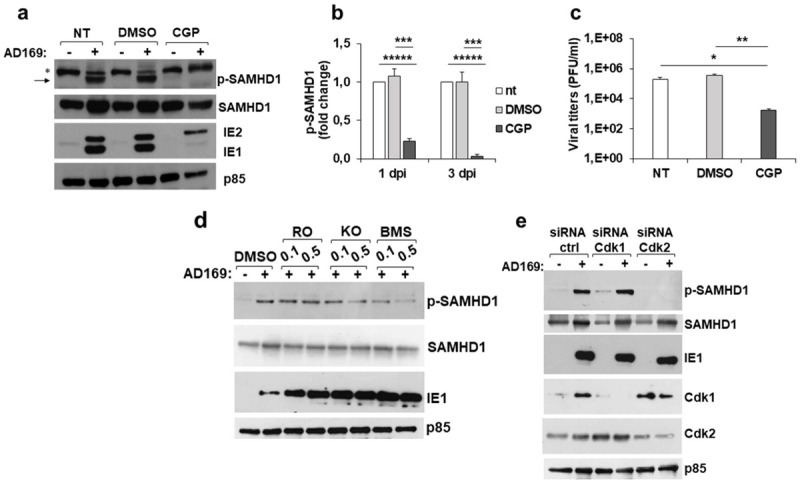
Inhibition of Cdk2 abrogates T592 phosphorylation.a) HFFs were pretreated for 5 h with the Cdk1 inhibitor CGP74514A (CGP), and then not infected or infected with AD169, in the presence of CGP. After removing virus inoculum, the inhibitor was newly added and kept until cell harvesting, at 3 dpi. Total or pT592-SAMHD1 levels were analyzed by immunoblotting, together with IE1/IE2 and p85 expression. A representative experiment out of five is shown. b) The relative amount of pT592-SAMHD1, normalized to that of p85, was determined by densitometric analysis and is relative to that of n.i. cells, which was arbitrarily set as 1. Data are expressed as mean ± SE of four independent experiments performed at 1 and 3 dpi. c) Effect of CGP on infectious virus production as measured by standard plaque assays on cell culture supernatants at 3 dpi. Results derive from seven experiments and are expressed as mean ± SE. d) HFFs were pretreated as in panel a) with the Cdk inhibitors RO-3306 (RO), KO-3861 (KO) or BMS-265246 (BMS) at the indicated concentrations (μM), and then not infected or infected with AD169, in the presence of the inhibitors. After removing virus inoculum, the drugs were newly added and kept until cell harvesting, at 1 dpi. Immunoblotting was performed as above. One representative experiment out of two is shown. e) HFFs were transfected with Cdk1 or Cdk2 siRNA or non-targeting siRNA (ctrl). The day after, cells were not infected or infected with AD169 at an MOI of 1 and harvested at 1 dpi. Immunoblotting was performed as above. One representative experiment out of two is shown. NT, not treated cells; DMSO, cells treated with the vehicle DMSO; *, unspecific band; black arrow, pT592-SAMHD1 specific band. *, p < 0.05; **, p < 0.01; ***, p < 0.001; ****, p < 0.0001; *****, p< 0.00001.